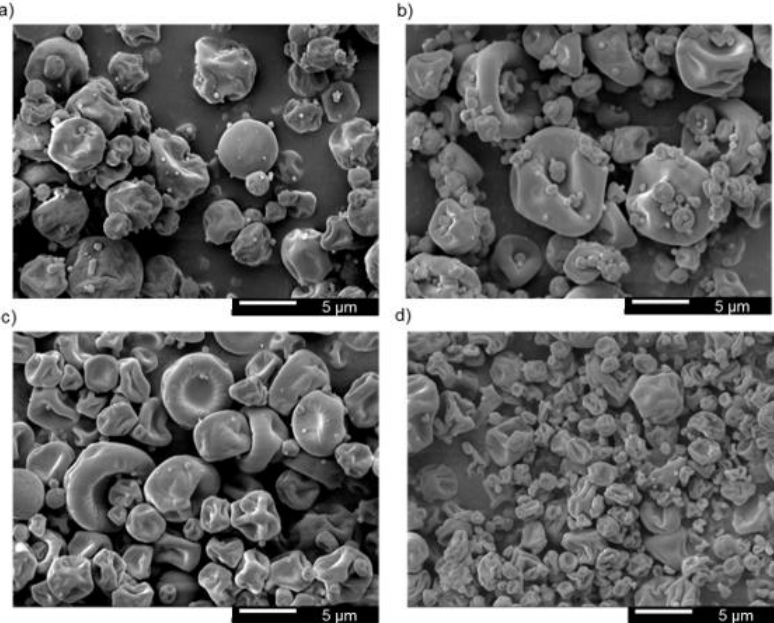
Figure 2. SEM microphotographs of 40:60 ( w / w ) itraconazole spray-dried solid dispersions (SDSDs) prepared using our miniaturized device with: PVPVA ( a ), PVPK30 ( b ), HPMCAS-LF ( c ), and Eudragit